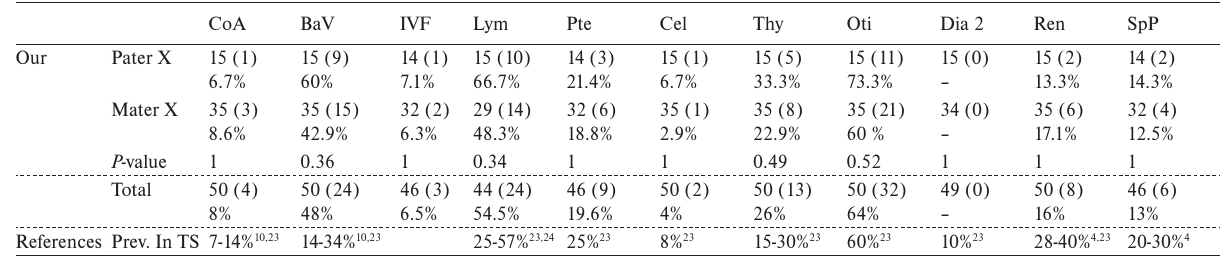
Table 1. Results of our TS cohort, haplotyping, presence of abnormality in subgroups.